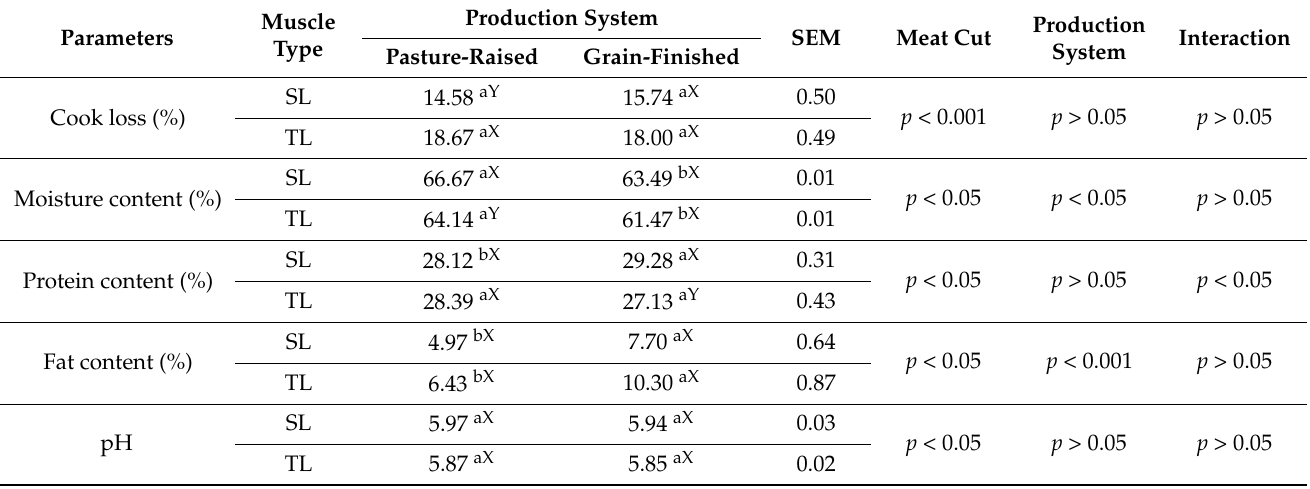
Table 1. Physicochemical analysis of cooked striploin (SL) and tenderloin (TL) from pasture-raised and grain-finished production